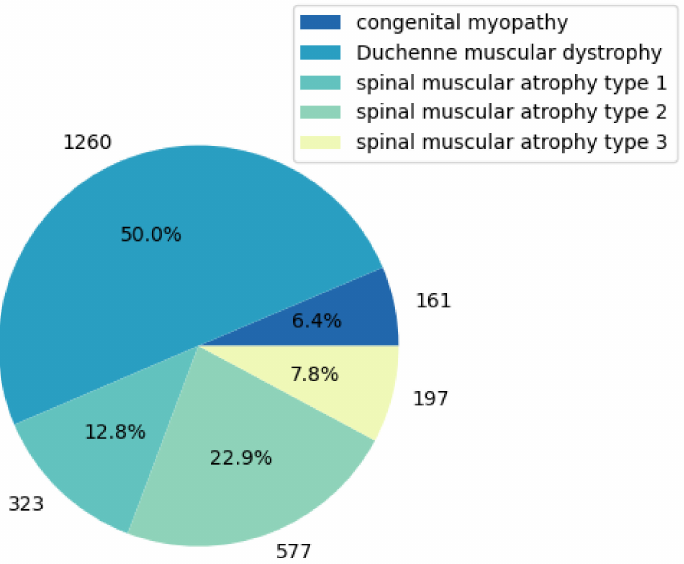
Figure 1. Types of diseases involved in the data and distribution of